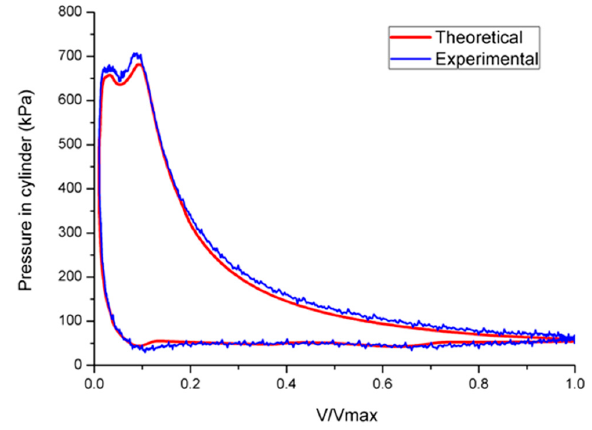
Figure 11. Comparison of the experimental and calculated p-V indicator diagram.